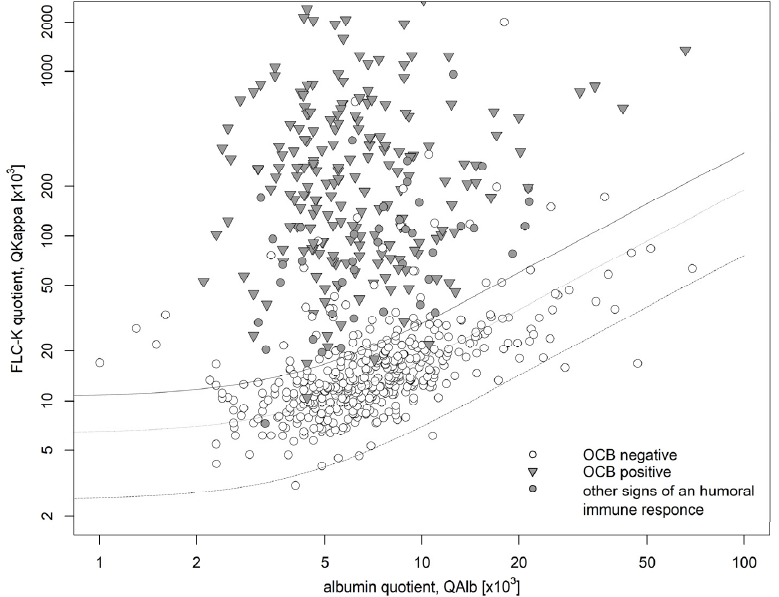
Figure 1. Data of the discovery cohort in a double logarithmic FLC κ quotient diagram. The bold line shows Qlim, the dashed line shows the Qmean. The bottom dashed line shows the Qlow. 302 sam-